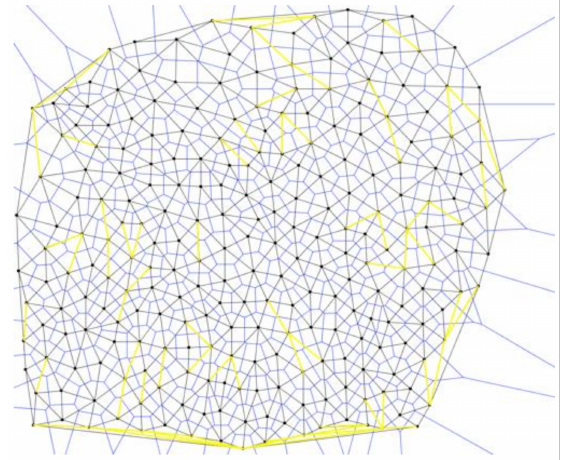
Figure 18. We illustrate the distribution of Pitteway violations (yellow edges) in a Voronoi tessellation of the epithelium of embryonic cells of Drosophila melanogaster. Data provided by [33]. The image was entered in Ka-me to illustrate the edges of the Delaunay triangulation of the Voronoi tessellation that cross more than one Voronoi edge (i.e., Pitteway violations).